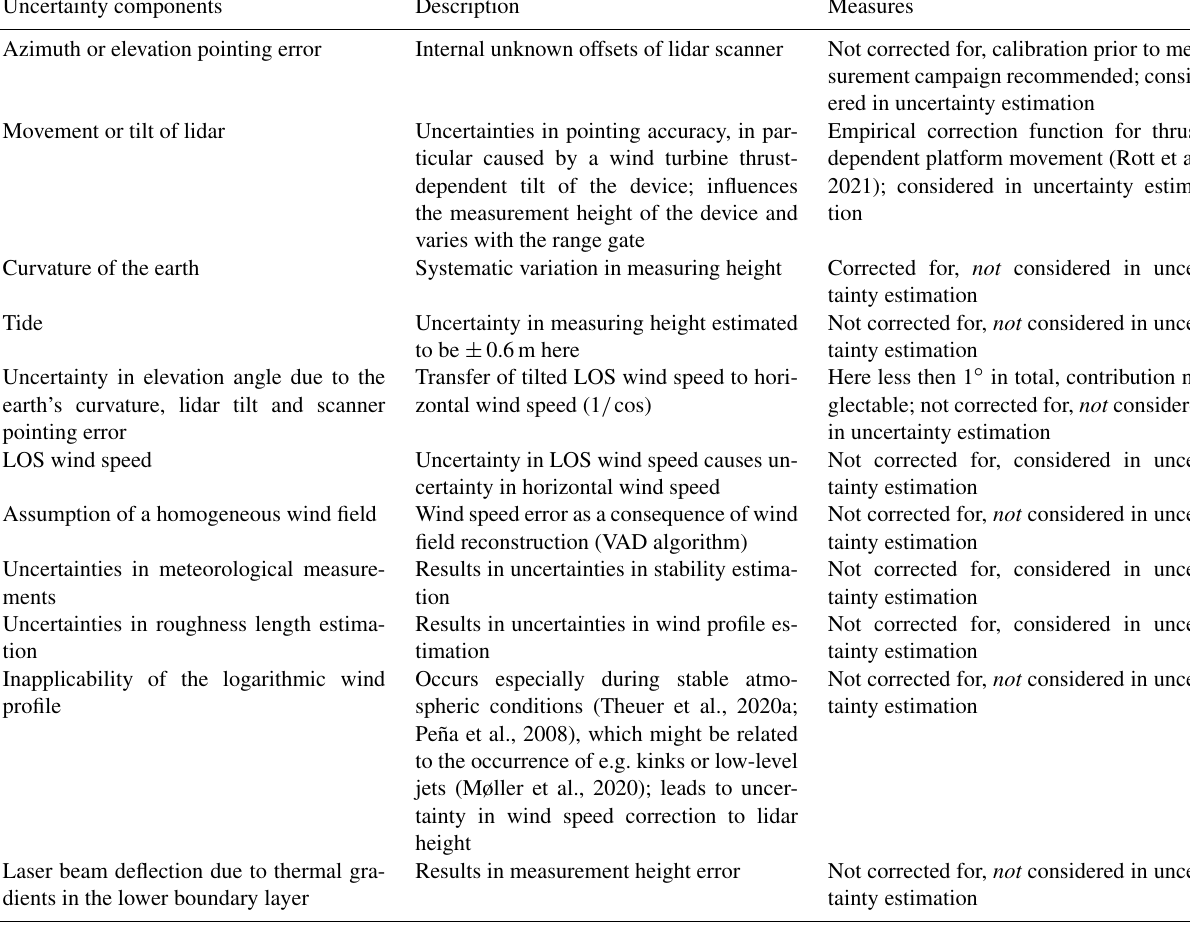
Table 2. Possible errors and uncertainties that might be introduced during the lidar measurement campaign and data analysis. In addition to a description of the uncertainty components, the measures we take to minimize those are stated, and it is indicated whether they are considered in the uncertainty